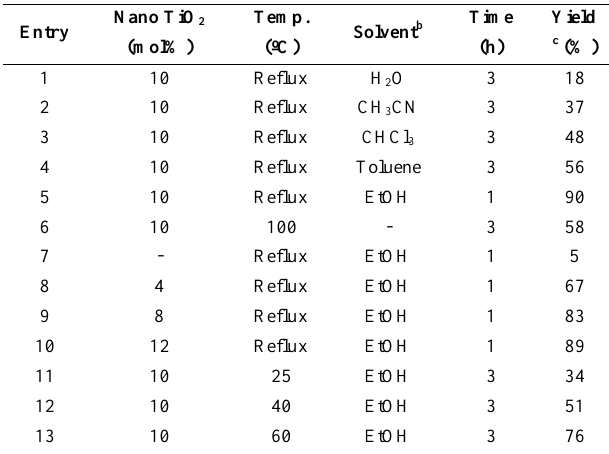
Table 1. The Effect of different conditions on synthesis of 1,8-dioxo-decahydroacridines a .